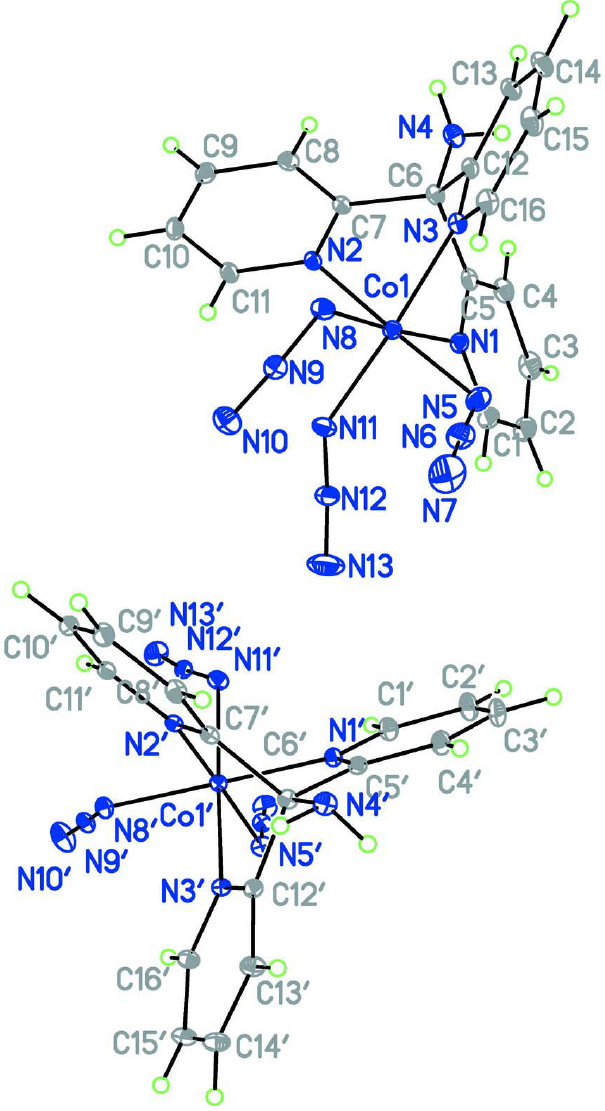
Two molecules in the asymmetric unit of the title compound with displacement ellipsoids shown at 30 % probability for non-H